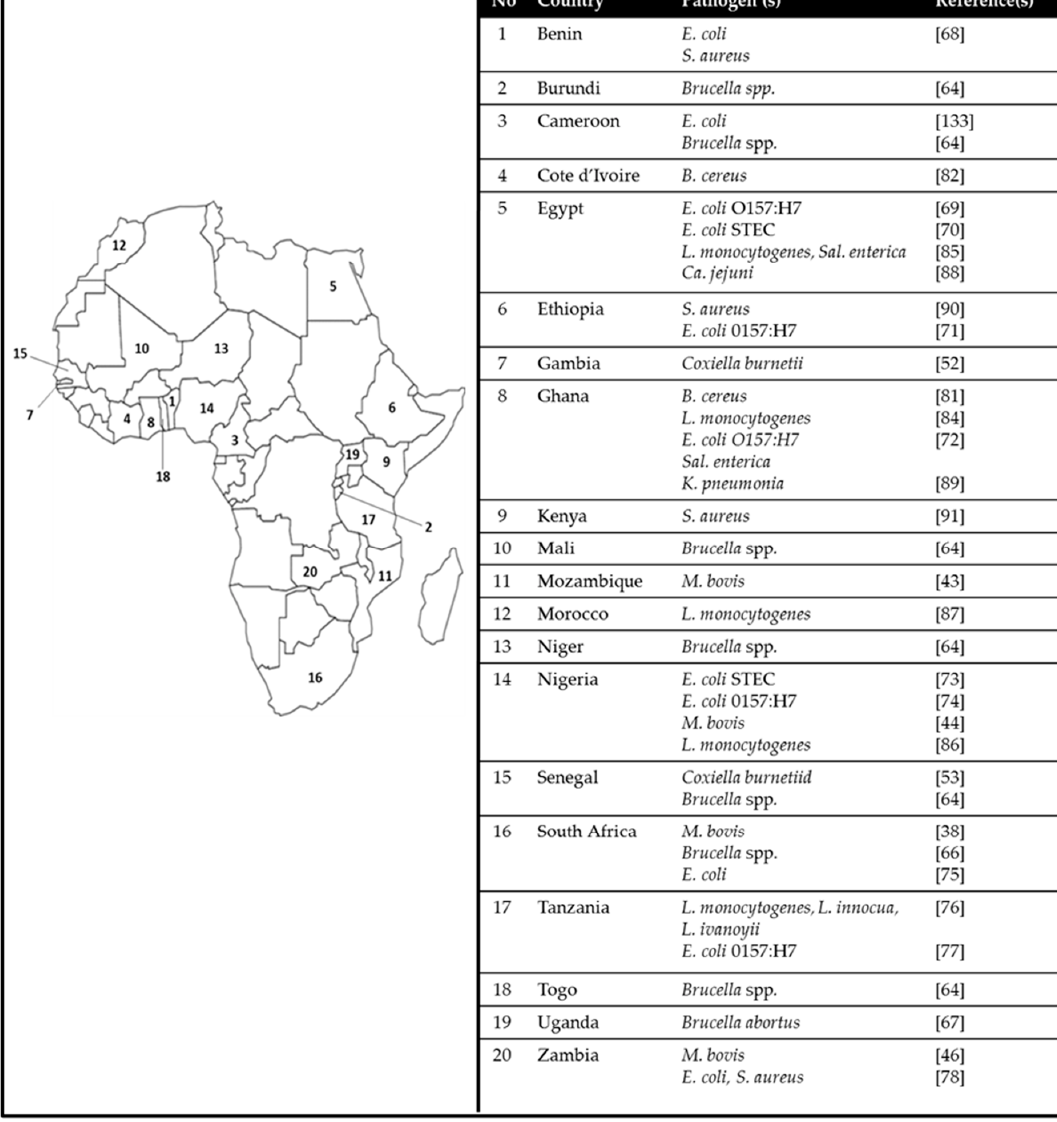
Figure 2. Pathogenic microorganisms occurring in milk and dairy products in some African countries. E .: Escherichia ; S. : Staphylococcus ; B .: Bacillus ; L .: Listeria ; Sal .: Salmonella ; Ca .: Campylobacter ; K .: Klebsiella ; M .: Mycobacterium .